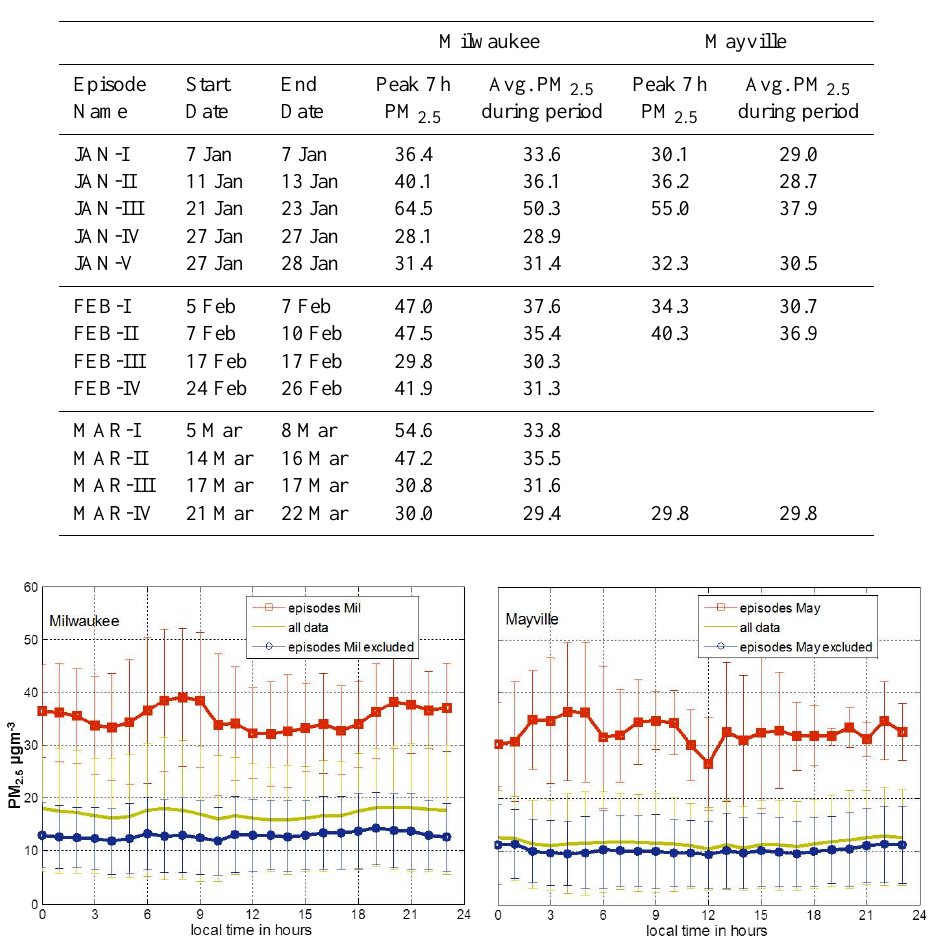
Table 5. Summary table for episodes.